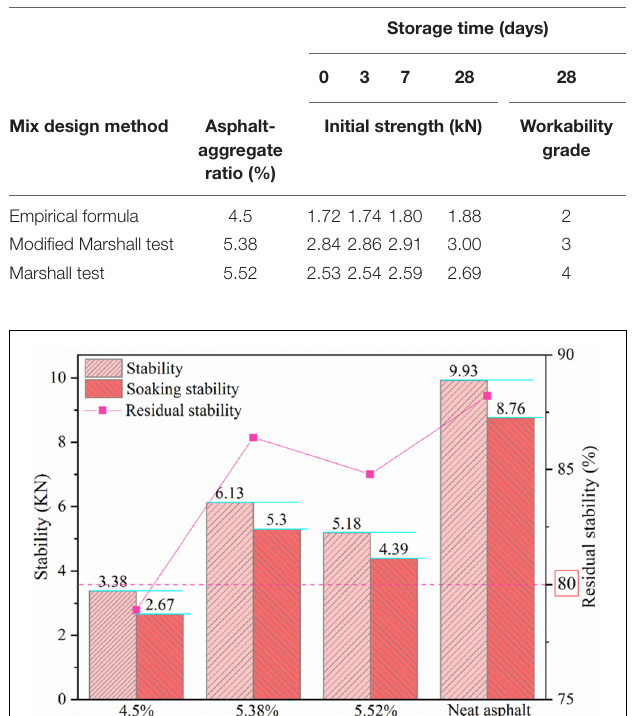
TABLE 9 | Storage performance test results for CPAM.